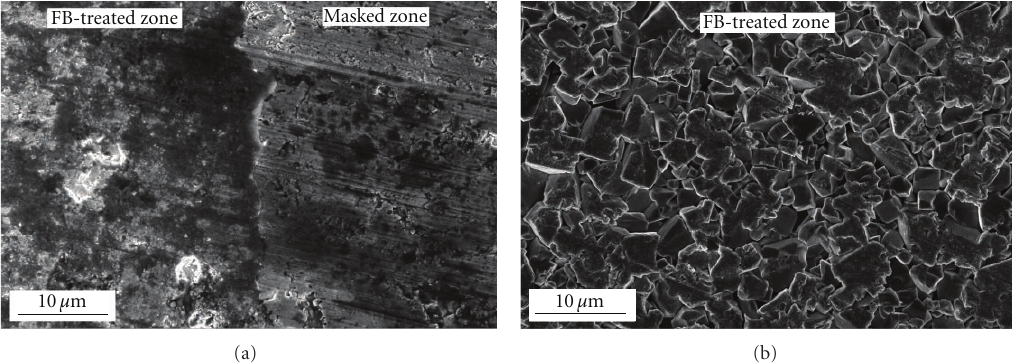
Figure 1: Morphology of WC-Co: (a) 16h FB and masked; (b) FB after etching.